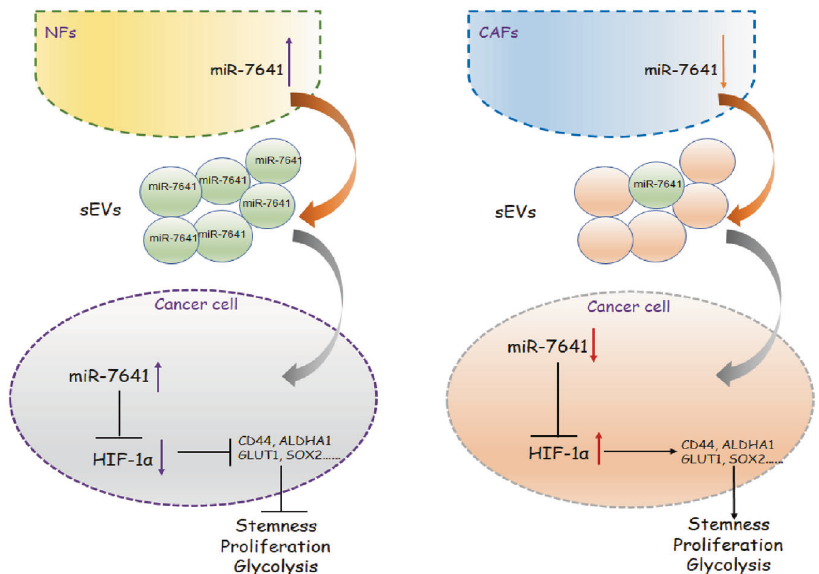
Fig. 7 A schematic diagram of the mechanism. CAFs derived sEVs with low miR-7641 promoted breast cancer cell proliferation, stem cell properties, and glycolysis via HIF-1 α